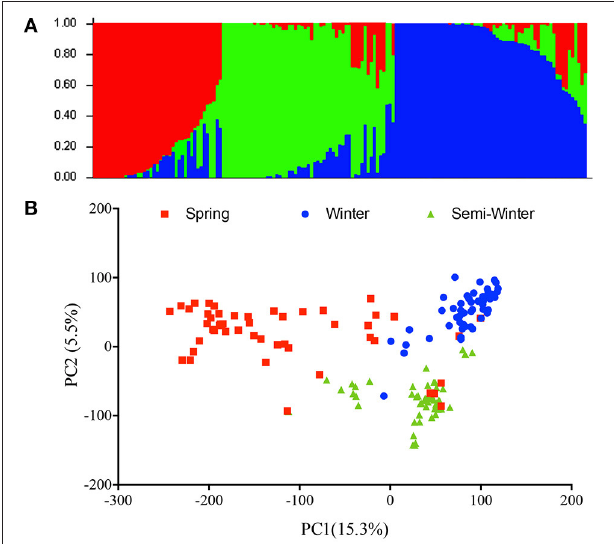
FIGURE 2 | Phylogenetic relationships among 157 inbred accessions. (A) Analysis of the population structure composed of 157 rapeseed lines with STRUCTURE. Each individual is represented by a vertical bar, partitioned into colored segments with the length of each segment representing the proportion of the individual’s genome, and with the same colored segment representing the same genomic components. (B) Principle component analysis. The first two principal components are shown. The individuals with the same label have the same